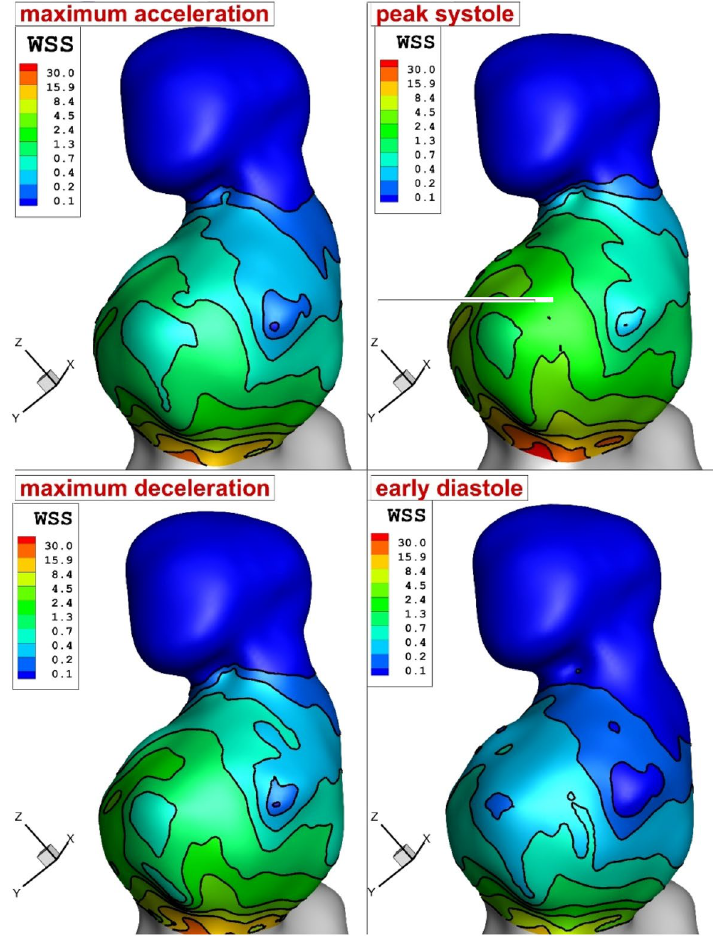
Figure 4. WSS distribution in different time